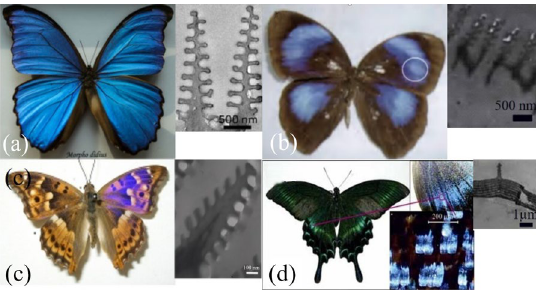
Figure 2 SEM image of blue scale of the morpho butterfly a from Ref. [26] and b from Ref. [29]; c Purple scale of Apatura laverna leech [31]; d Blue scale of Papilio maackii Menerries